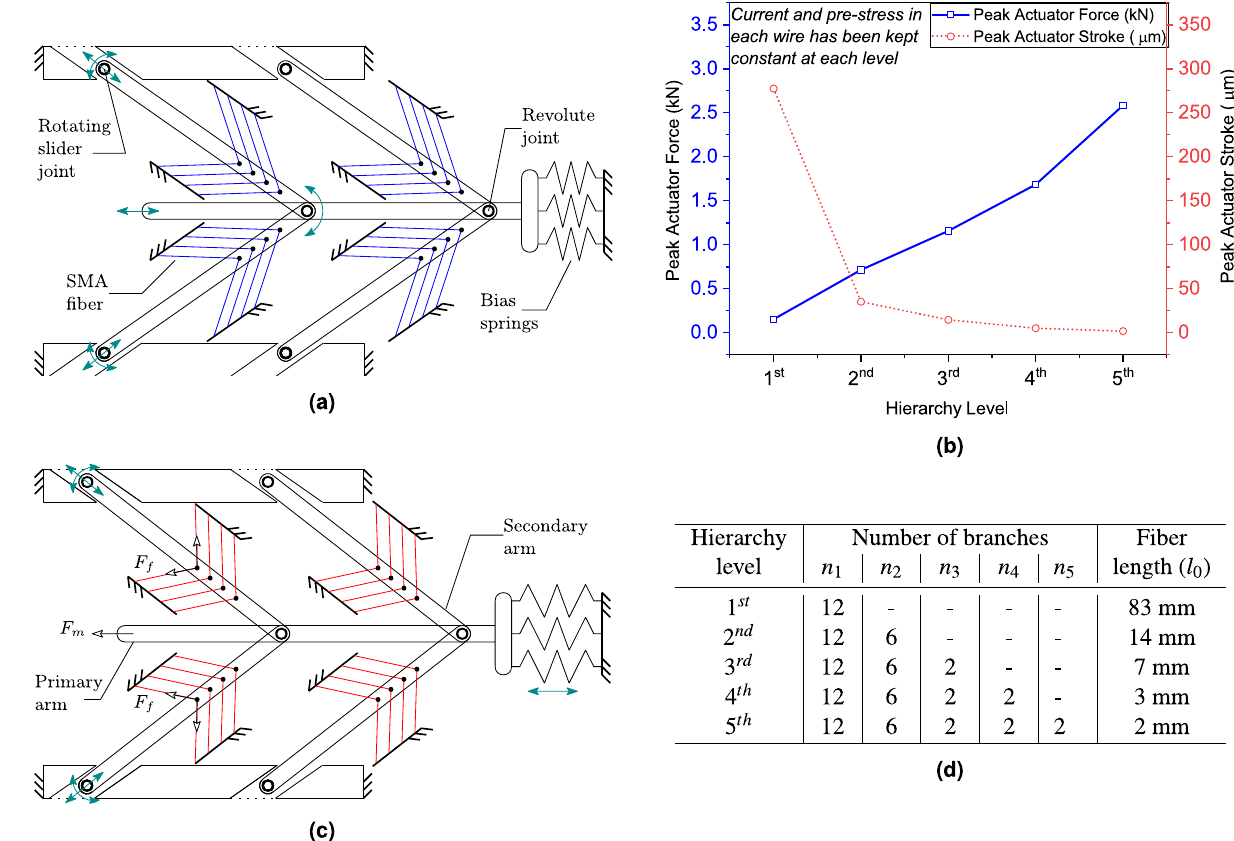
Figure 7. ( a ) A shape memory alloy-based two-stage ( N = 2 ) hierarchical linear actuation system is depicted in a bipennate configuration. The suggested model is implemented by replacing the SMA wires in the 1st level hierarchical actuator with another single stage hierarchical actuator. ( c ) depicts the deformed configuration of the 2nd level hierarchical actuator. ( b ) The distribution of force and displacement as a function of the number of hierarchy levels has been depicted. The peak actuator force has been found to be positively linked with hierarchy level in the graph, whereas the stroke has been shown to be inversely correlated with the hierarchy level. Throughout all the levels, the current and pre-stress in each wire were kept constant. ( d ) Table illustrates the number of branches in each level and the length of SMA wires (fibers). The wire characteristics are denoted by subscript 1, and the number of secondary arms (one attached to the primary arm) is denoted by the maximum number in subscript. For example, in level 5, n 1 refers to the number of SMA wires present in each bipennate structure, whereas n 5 refers to the number of secondary arms (one attached to the primary